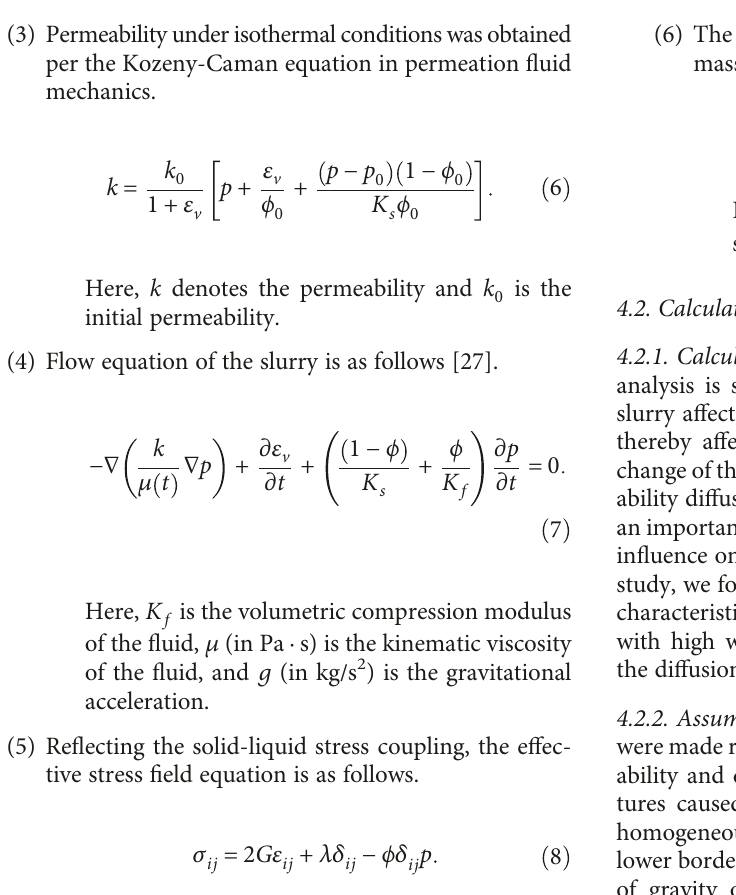
Figure 10: Microstructure observation of coal masses bound with cement and expandable material with high water content: (a, b) 200x magni fi cation and (c, d) 2000x magni fi